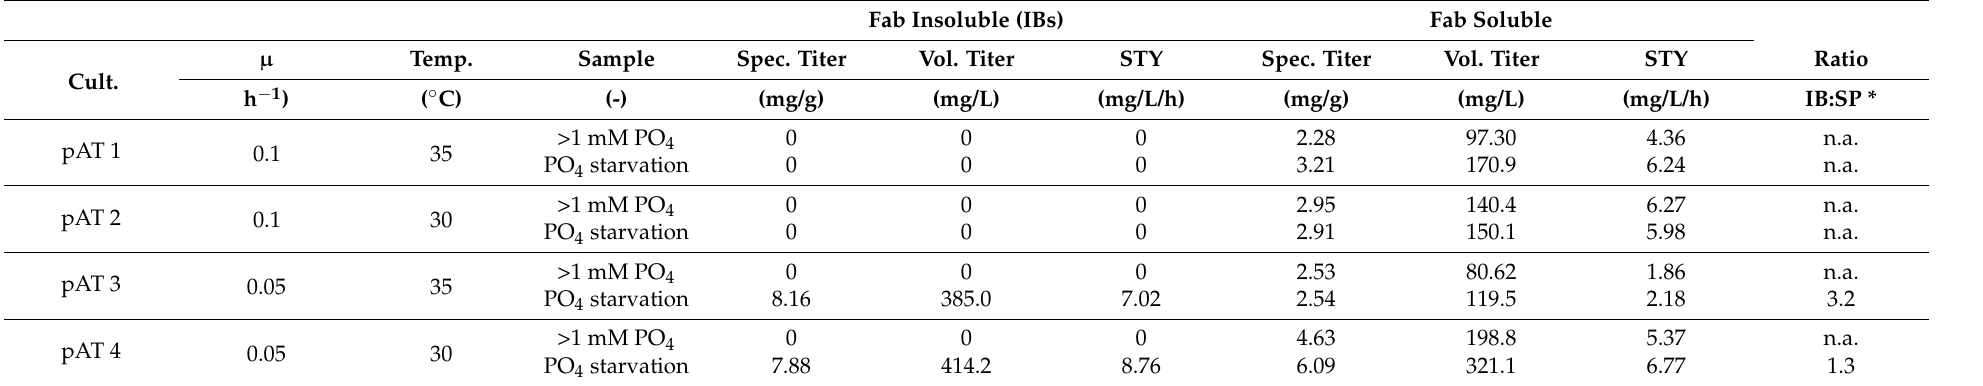
Table 5. Fab productivity for pAT